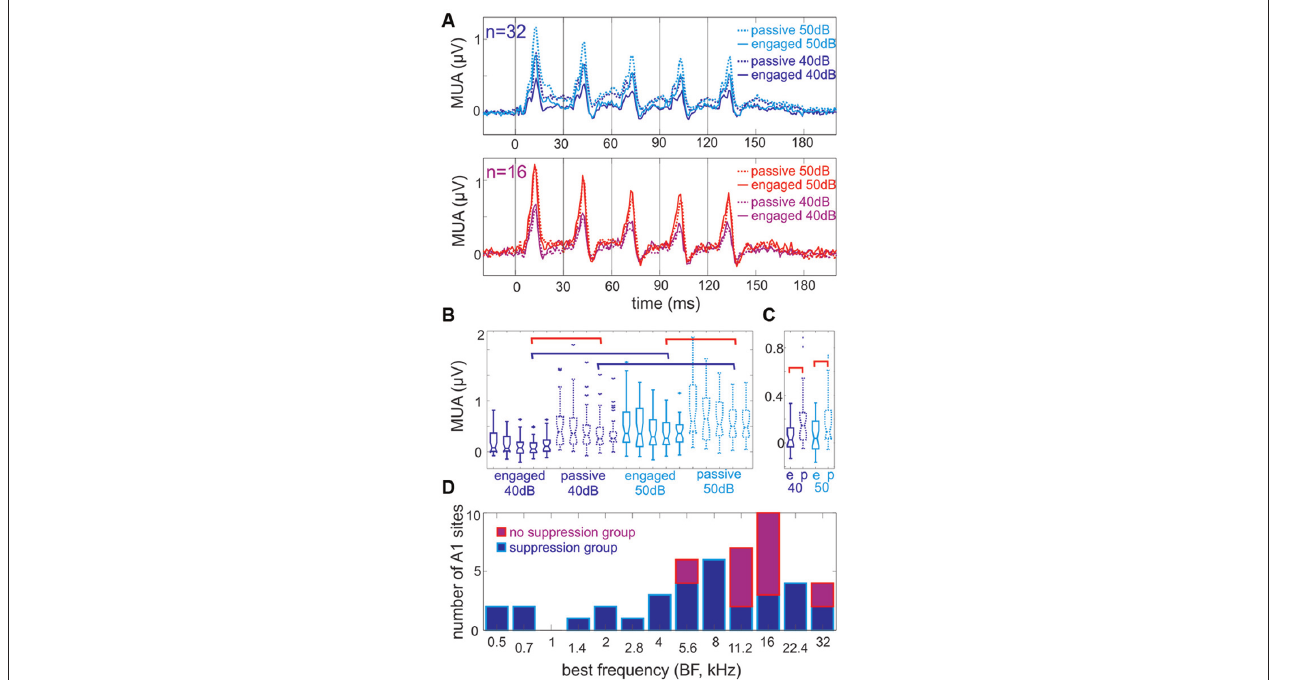
FIGURE 2 | Engagement generally suppresses responses to click-trains. (A) Multiunit responses to click-trains. Top traces show averaged responses to click-trains presented at 40 and 50 dB loudness (dark vs. light blue), in engaged and passive trial blocks (solid vs. dotted traces), recorded in Auditory cortex